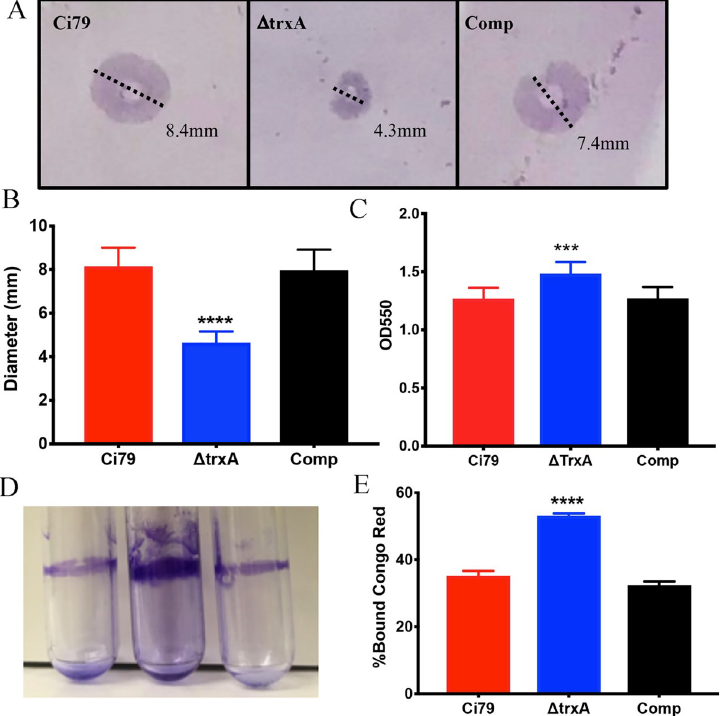
Fig 3. Comparison of growth characteristics and phenotype of wild type (Ci79), trxA mutant, and complemented bacterial strains. Twitching motility was measured by growing bacteria in a 0.3% LB agar plate that had been inoculated at the agar/plate interface. (A) Representative images depicting motility measurement, and (B) overall spreading distance (mean ± SD). Biofilm was measured by growing bacteria for 24 hrs in a static incubator at 37 o C. (C) Quantitation of biofilm formation in 96 well format. (D) Visual comparison of biofilm formation in polystyrene tubes. Congo Red binding (E) was assessed on mid-log phase bacteria. Error bars represent SD. Bar charts represent one set of data from 3 independent studies, each consist of 6 samples for each bacterial strain. Statistical differences were determined by two-way ANOVA with Holm-Sidak correction for multiple comparisons ( ��� P < 0.001, ���� P <